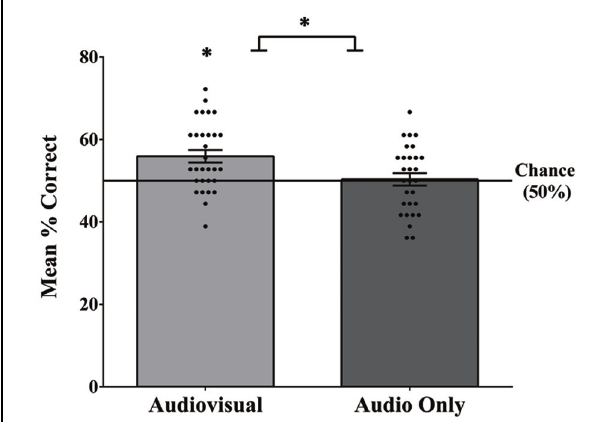
FIGURE 2 | Mean accuracy, as well as each individual score on segmentation test for the audiovisual and audio-only familiarization conditions. Performance in the audiovisual condition was significantly above chance and was significantly greater than the audio-only condition. Error bars denote ± 1 SEM. ∗ denotes significance at 0.05